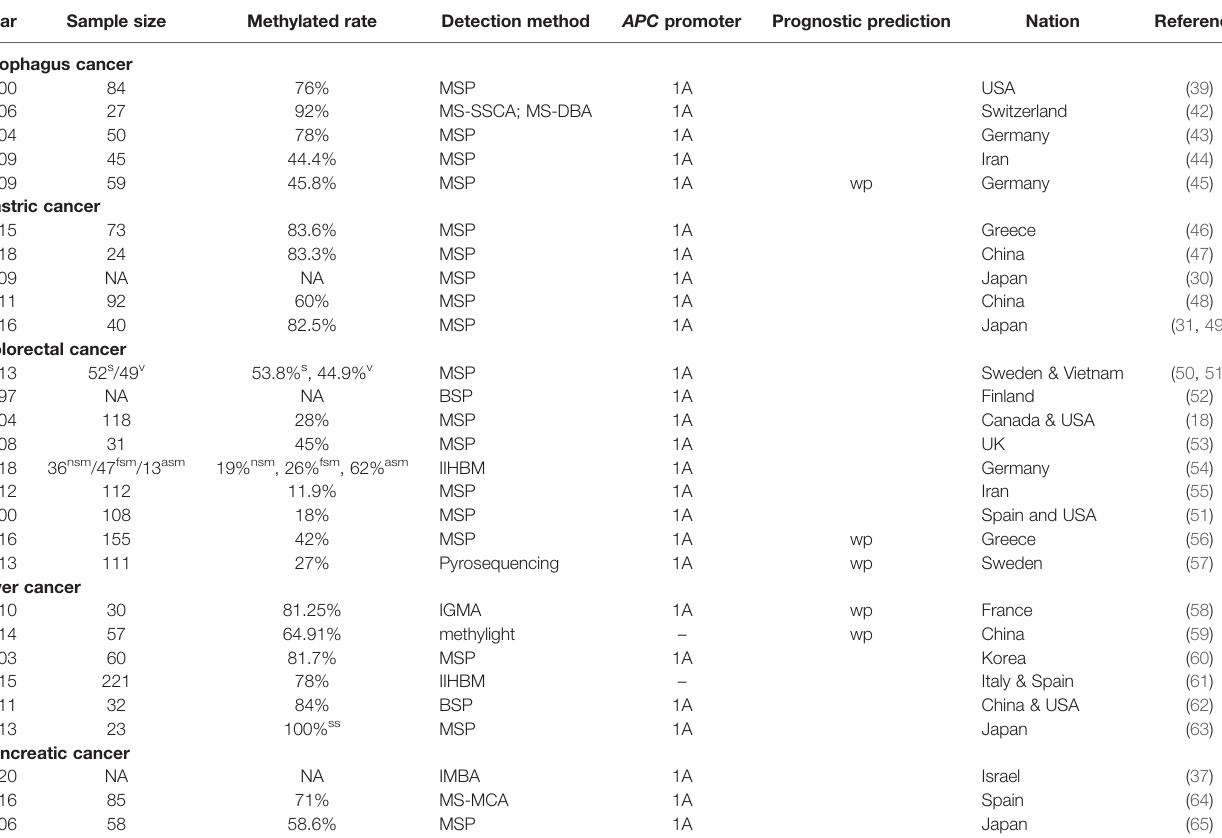
TABLE 1 | Methylation methods and methylation rate in each GI